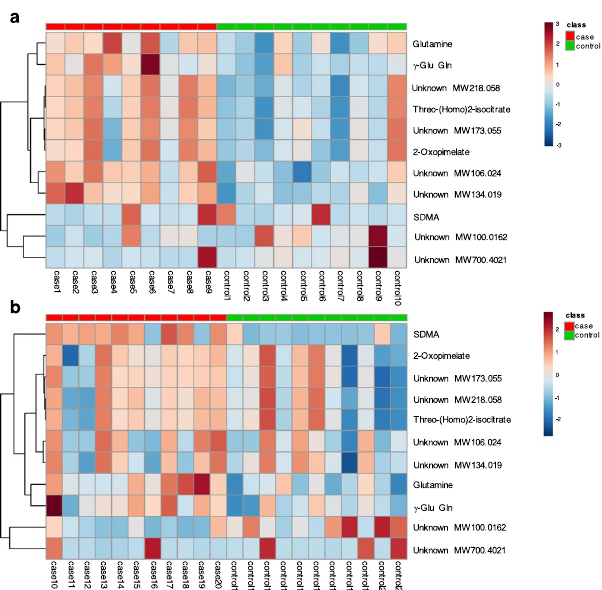
Figure 3. Breed-specific heat maps of metabolic differences between fearful and non-fearful dogs. ( a ) Metabolic differences between fearful and non-fearful German Shepherds. ( b ) Metabolic differences between fearful and non-fearful Great Danes. Heat maps were generated with hierarchical clustering. Included are statistically significant metabolic features having VIP > 1, FC ≥ ± 1.2 and Mann-Whitney U p FDR < 0.05. The metabolites are listed at the left side of each row, and the subjects are shown at the bottom of each column. The colour scale indicates high ( red ) or low (blue) metabolite abundance. SDMA, symmetric dimethylarginine; γ -Glu Gln, γ